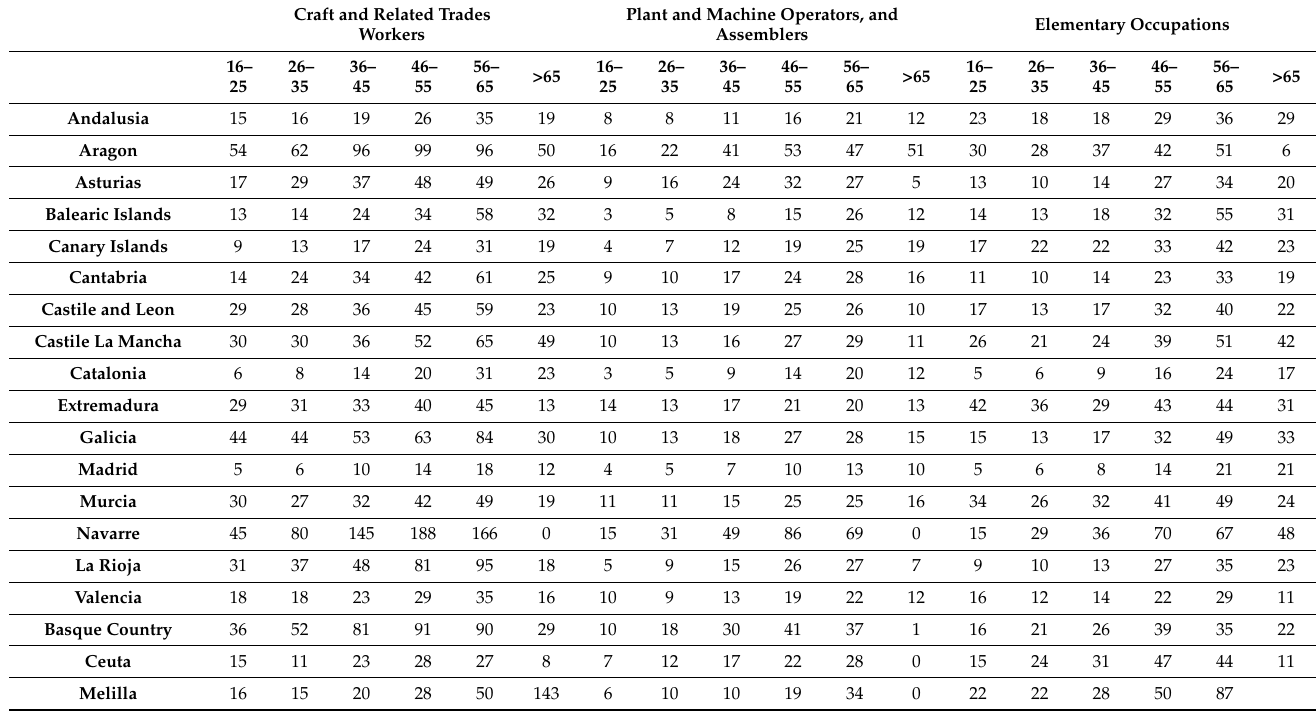
Table 5. Average duration of sickness absence by aged ranges and ISCO-08